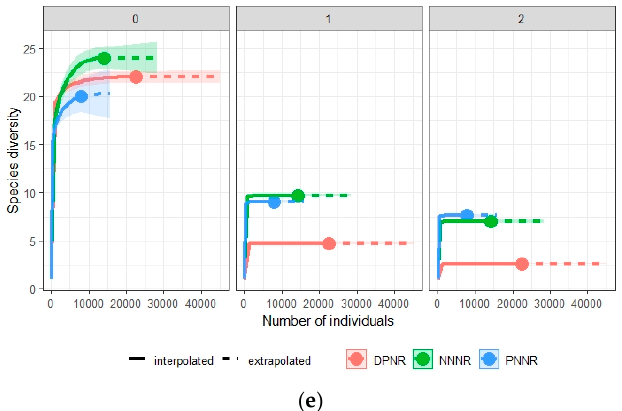
Figure 3. Rarefaction and extrapolation based on Hill numbers (for order q = 0, 1, 2), species richness (q = 0), Shannon’s diversity (q = 1) and inverse Simpson’s diversity (q = 2) of reference sample collected from the study sites in the five consecutive survey years (( a ). Survey 1; ( b ). Survey 2; ( c ). Survey 3; ( d ). Survey 4; ( e ). Survey 5) 2016–2020. The solid line is the rarefaction curve and the dotted line is the extrapolation curve, which goes up to double the size of the reference sample. The shaded area represents 95% confidence intervals obtained using the bootstrap method based on 200 replication.